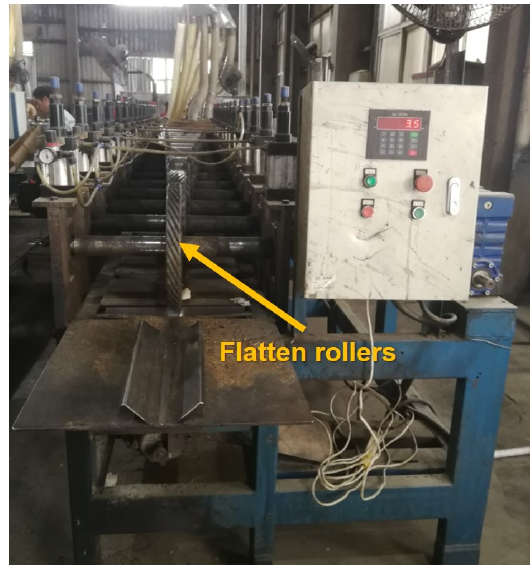
Figure 1. The bamboo longitudinal flattening machine.